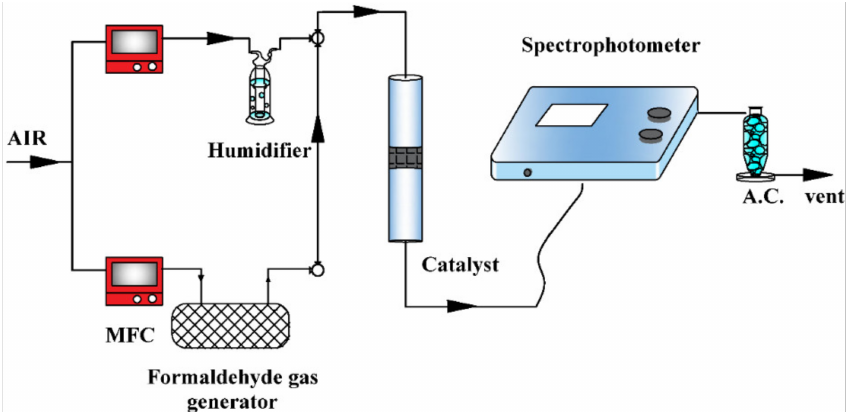
Figure 10. Schematic illustration for catalytic activity